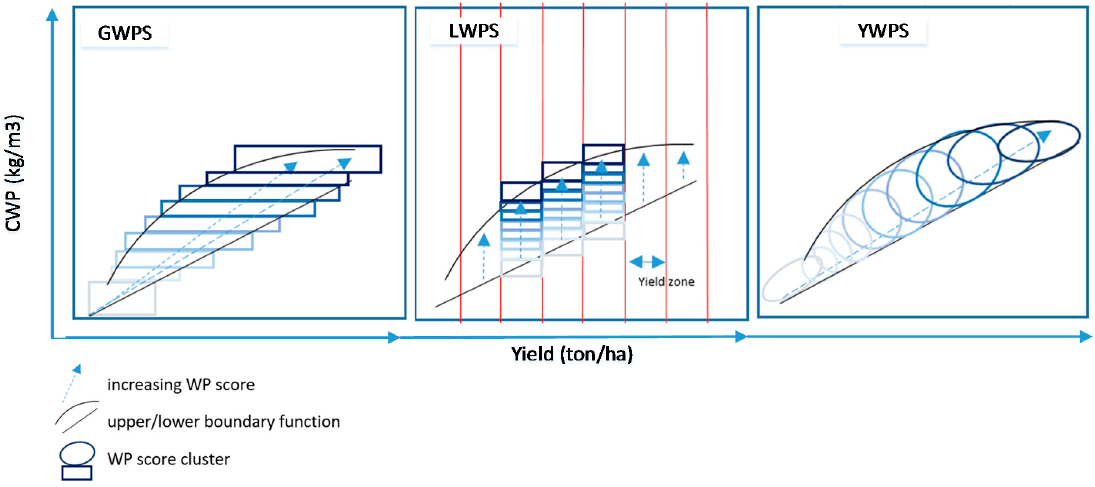
Figure 1. Conceptual approach to setting crop water productivity (CWP) targets under the global water productivity score (GWPS), local water productivity score (LWPS) and land and water productivity score (YWPS).